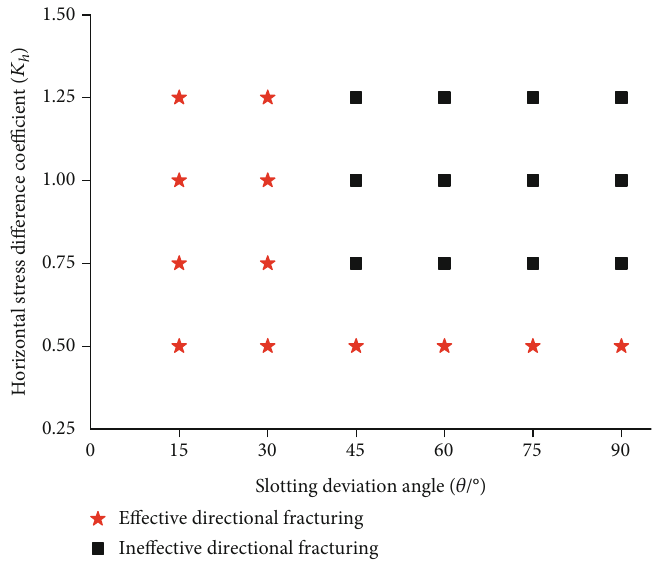
Figure 10: E ff ective directional fracturing results obtained from the 24 models.